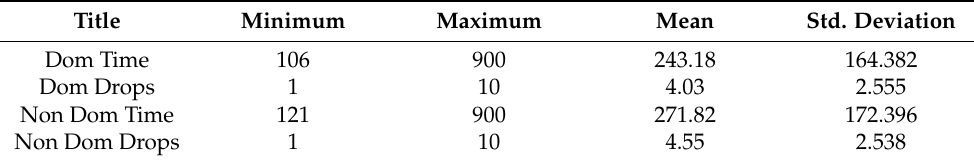
Table 5. Grooved Pegboard Descriptive Statistics (n = 33).